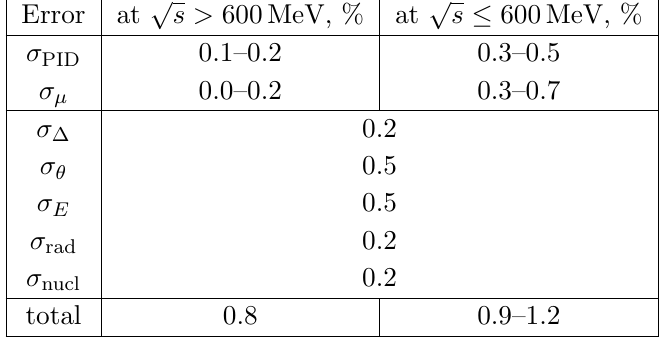
Table 2 . Various contributions to the systematic error of the e + e (cid:0) ! (cid:25) + (cid:25) (cid:0) cross section mea-